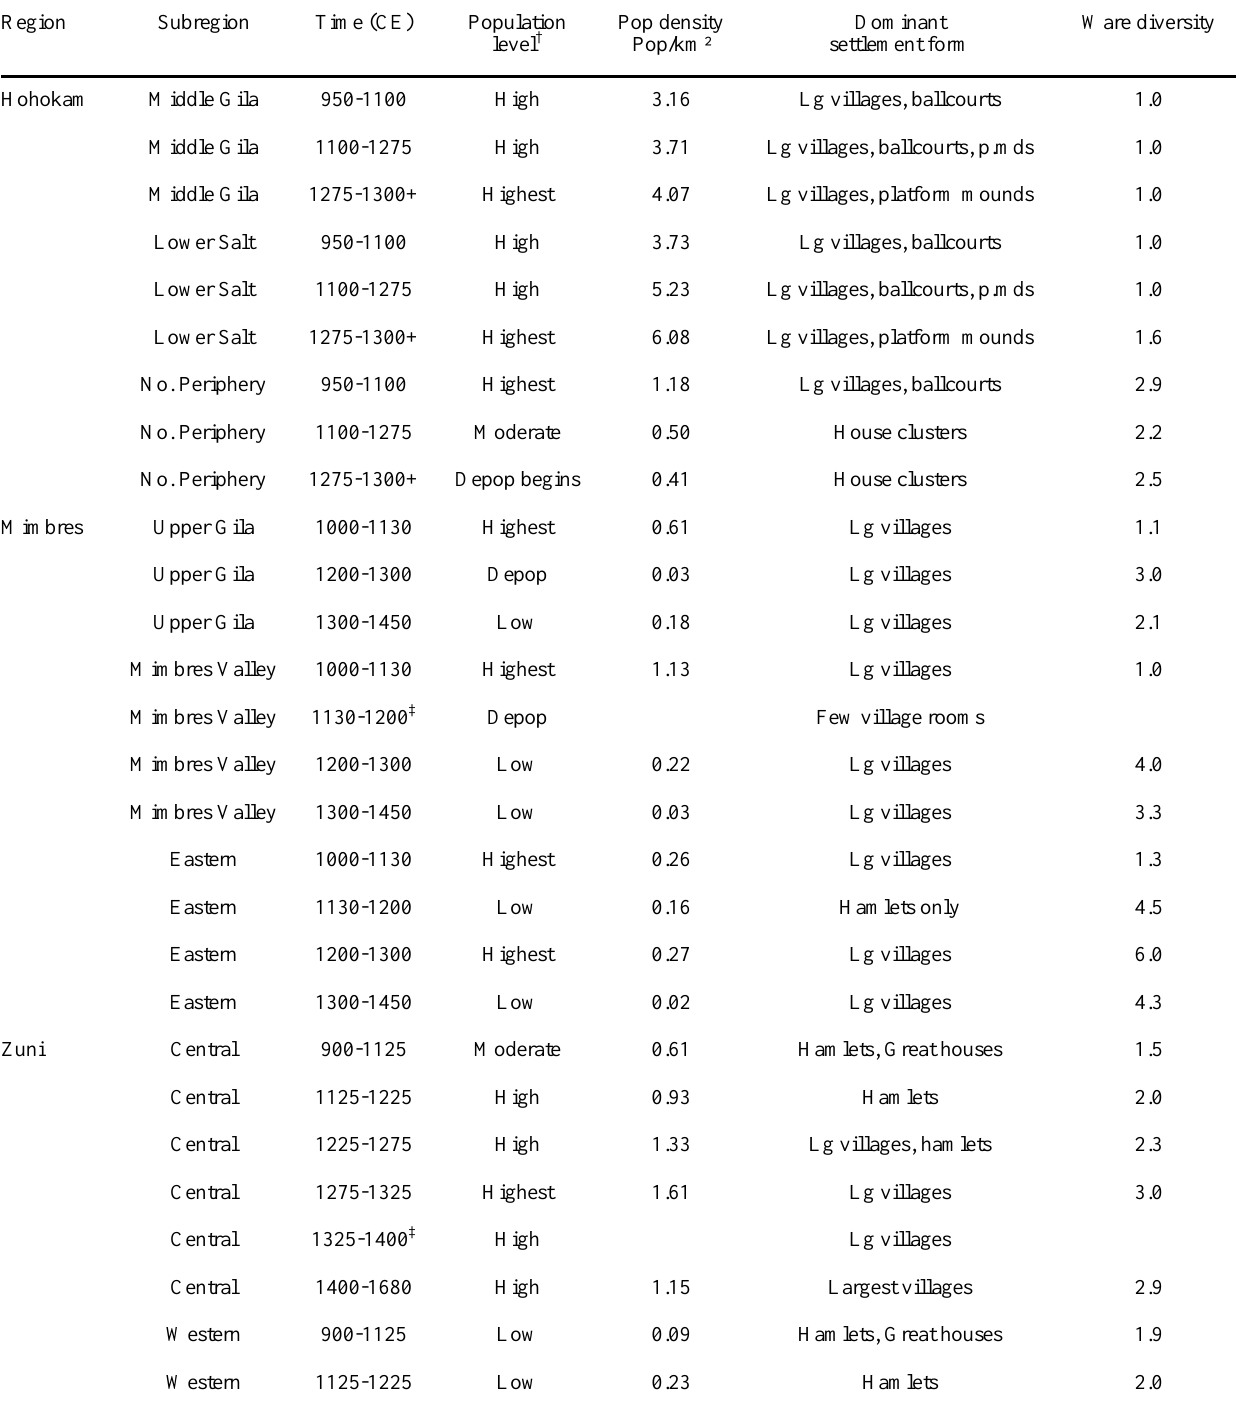
Table 1 . Population, ceramic, and settlement data for time-space units in the four regions of the US Southwest. Periods preceding major transformations are